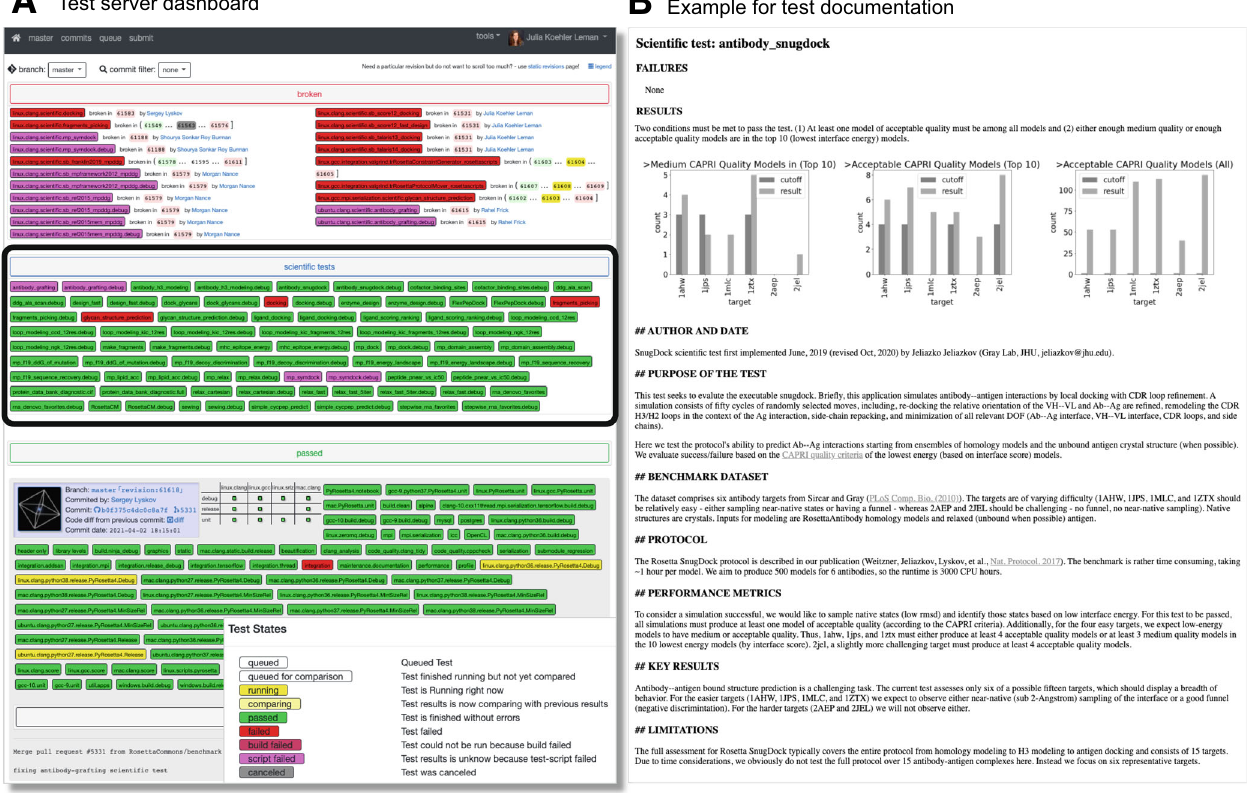
Fig. 2 Webpages for the main dashboard and documentation of the tests. A Dashboard of our benchmark server testing infrastructure. Each test is colored according to its test results: red denotes breakage, magenta denotes script failure, green denotes passing of a test, yellow denotes the test is currently running, and white denotes the test has yet to be run. All broken tests are shown prominently at the top of the page. All scienti fi c tests are shown in the blue tab below (also encircled in bold black). Tests of the latest revision merged into the main branch are shown below with information about the committer, the pull request ID, a link to the code difference, and the commit message. B The results page shows the results of the run, the documentation, and the description of whether the test passes or fails. Results pages are automatically generated at the end of the run for each